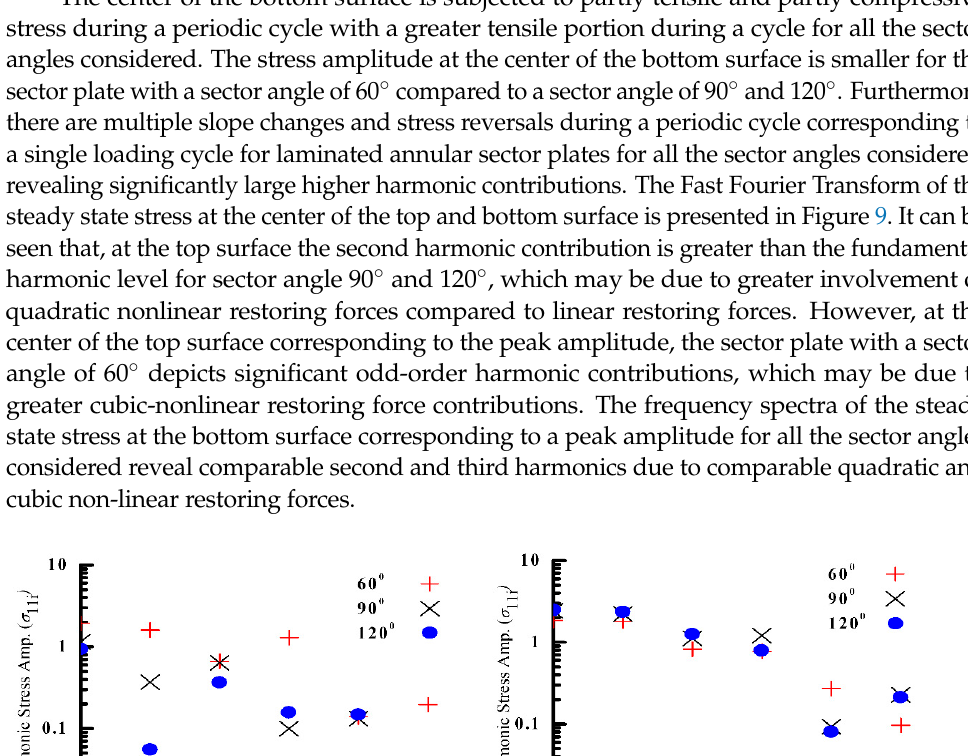
Figure 8. Periodic stress ( σ 11) distribution corresponding to peak amplitude in the Figure 6.